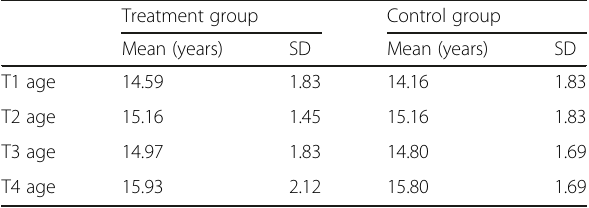
Table 1 Age descriptive statistics for treatment and control subjects Treatment